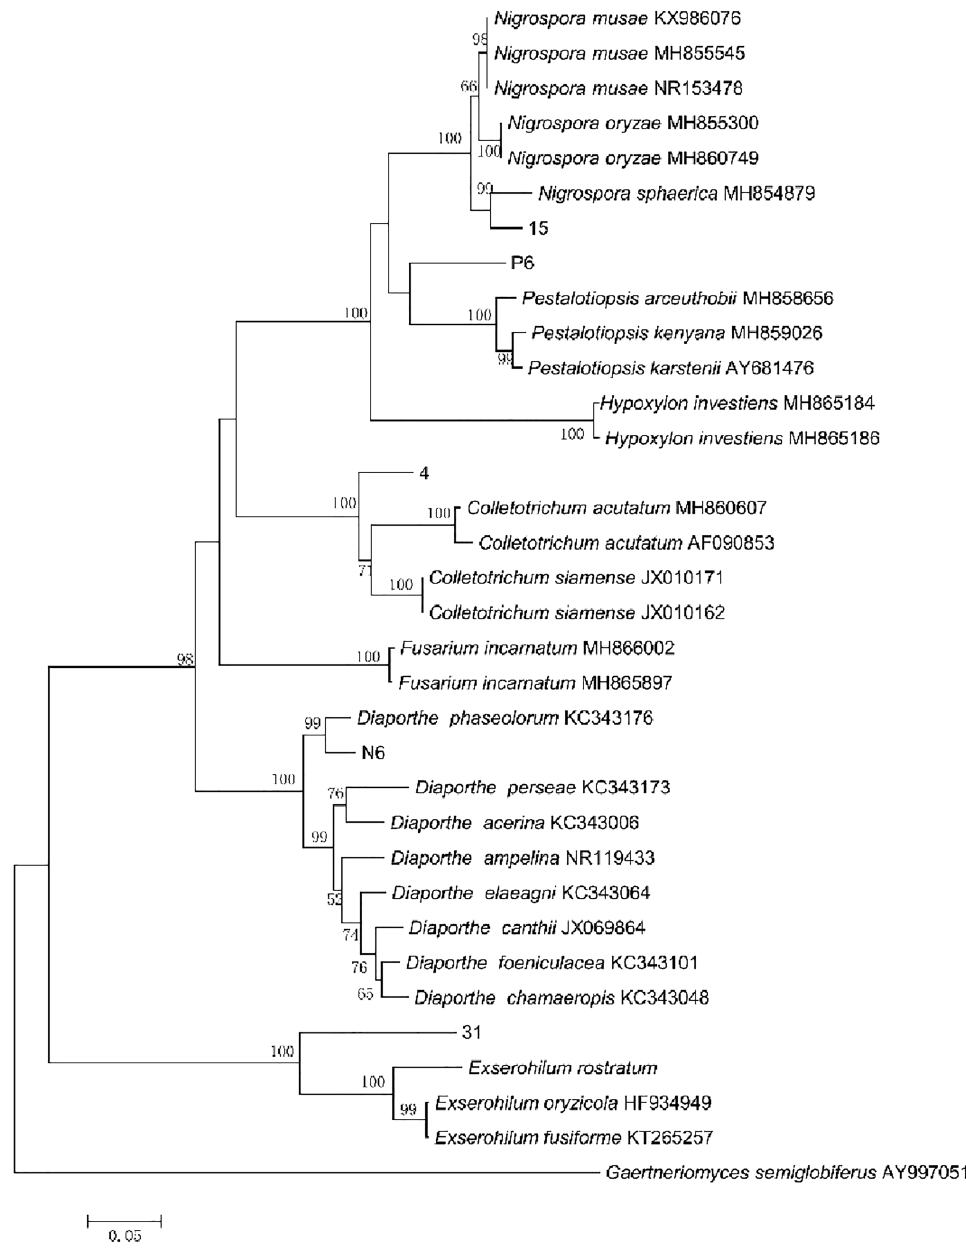
Figure 3. Phylogenetic tree constructed based on ITS rDNA and beta-tubulin sequences. Bootstrap values > 50% (1000 replication) are given at the nodes. Gaertneriomyces semiglobiferus was used as the